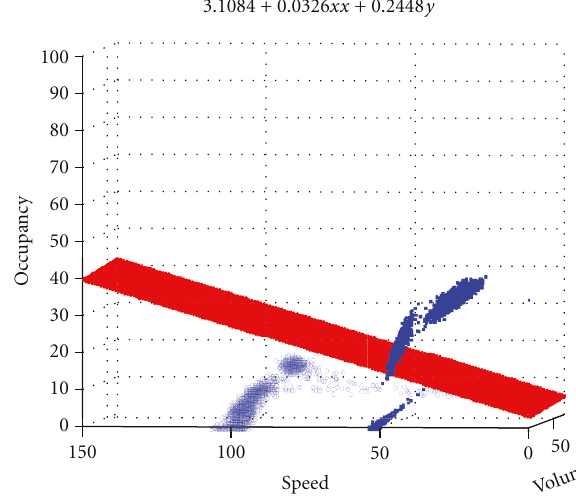
Figure 16: Plane of FD-SVM for